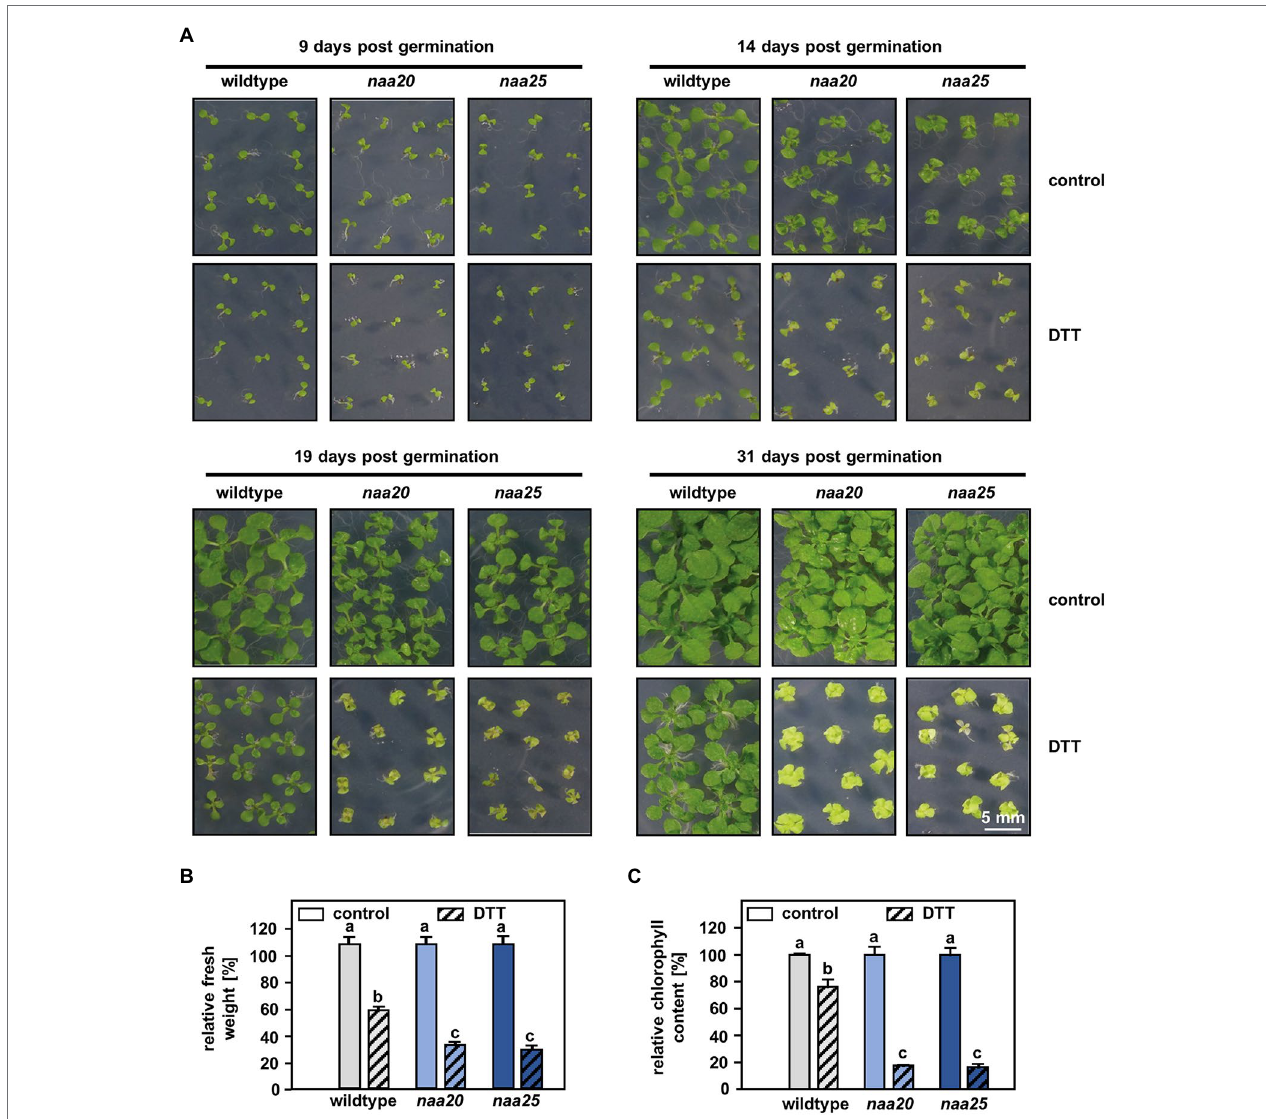
FIGURE 1 | NatB mutants are sensitive to reductive stress. (A) Seeds of NatB mutants and wildtype plants were surface sterilized, stratified, and germinated on 1×MS medium. After 3 days of growth under short-day conditions, the seedlings were transferred to 1×MS plates (control) or 1xMS plates supplemented with 2 mM DTT (DTT). Pictures show the growth of seedlings at different time points post-germination (scale bar = 4 mm). The relative fresh weight (B) and relative chlorophyll content (C) of the plants were determined 31 days post-germination. Data given as means ± SE. Different letters indicate individual groups identified by pairwise multiple comparisons with a Holm-Sidak, One-way ANOVA ( p < 0.05, n = 4, 1n = 5